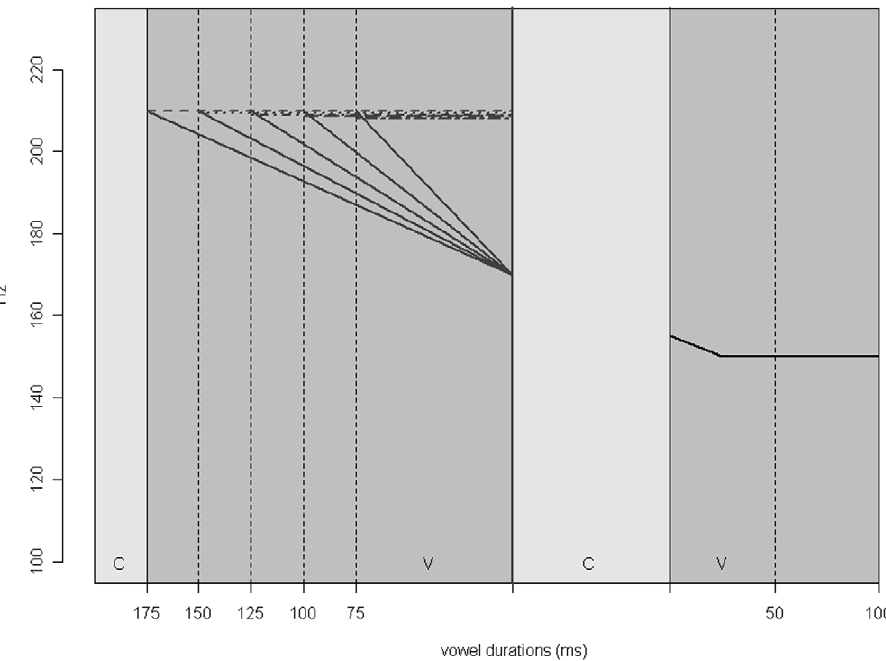
Figure 4. Schematic representation of the construction of materials in Experiment 1.